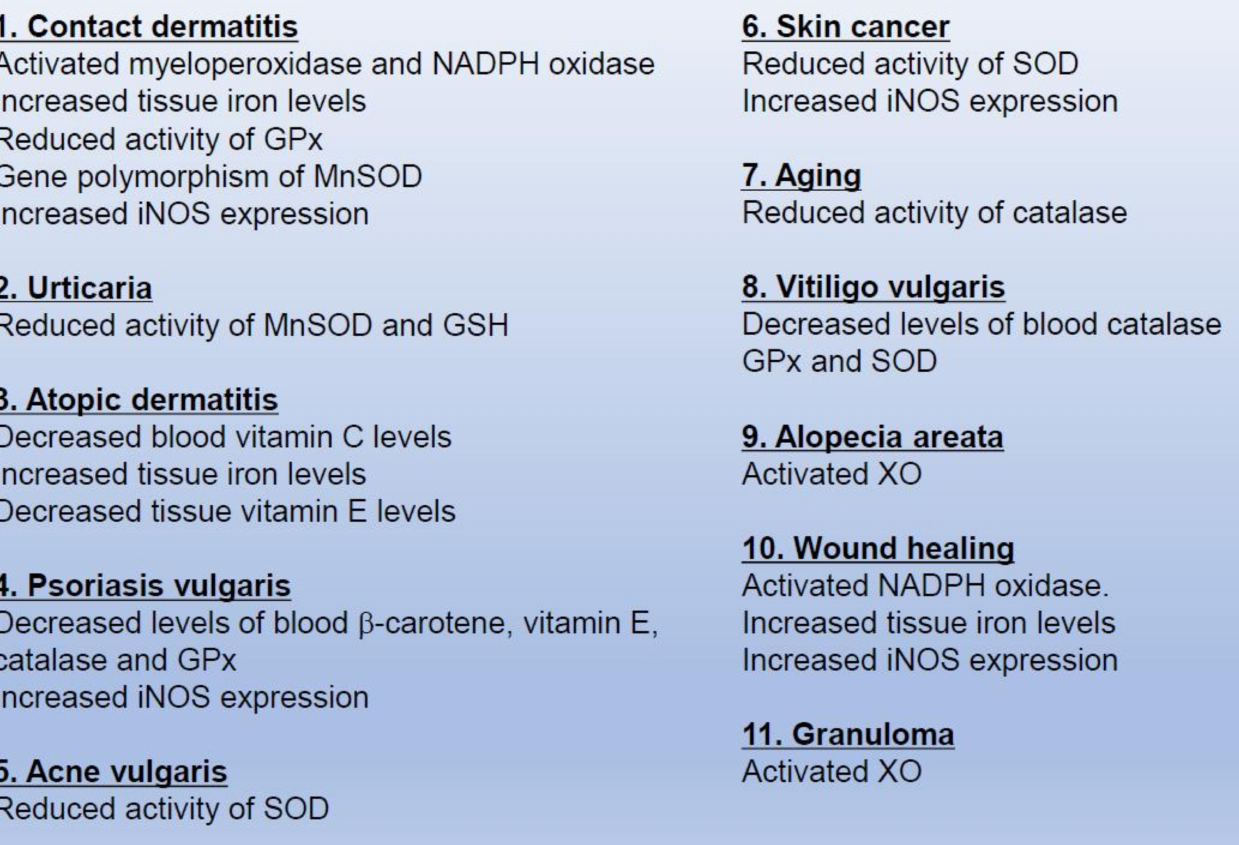
Figure 7. Representative reported abnormalities in the production of reactive oxygen species in skin